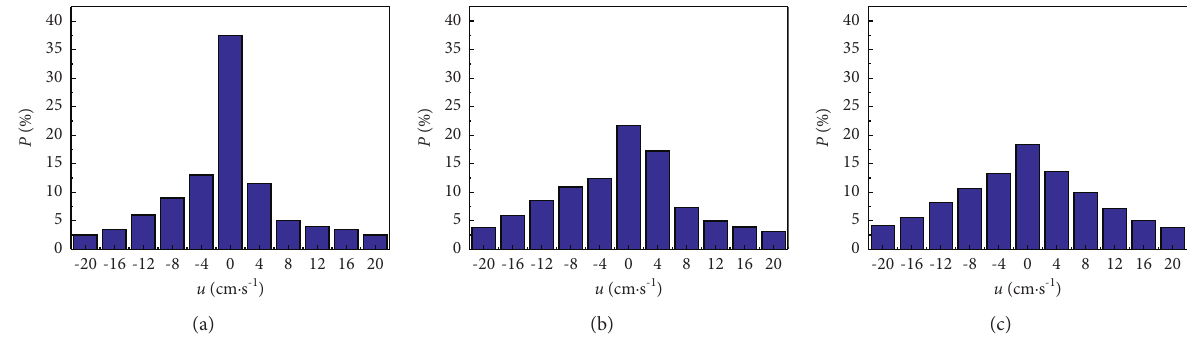
Figure 5: The probability distribution of longitudinal pulsation velocity in different working conditions. (a) B25S. (b) B25M. (c) B25L.